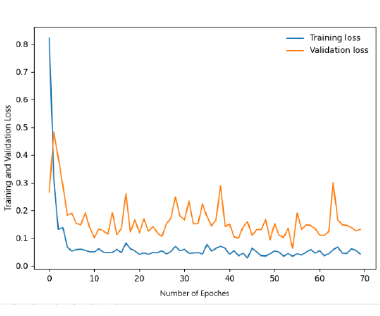
Figure 14 . Loss in ResNet50